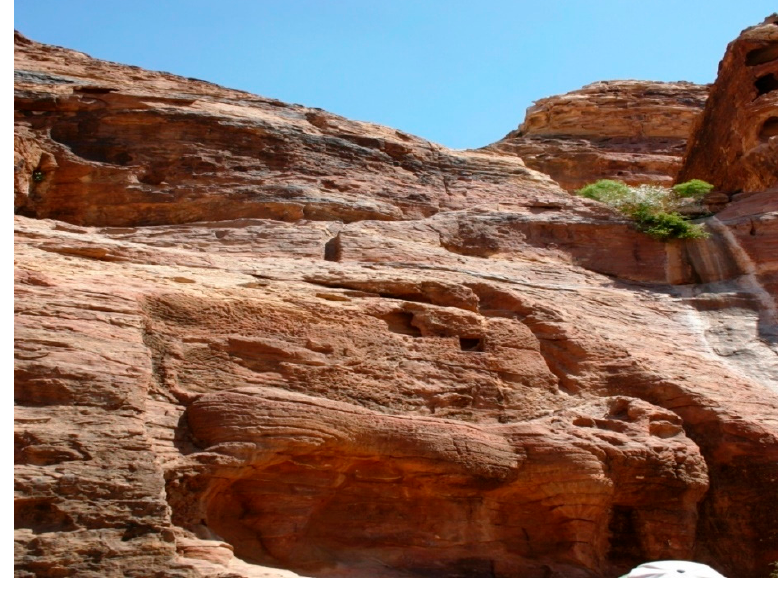
Figure 19. The Lion Fountain.